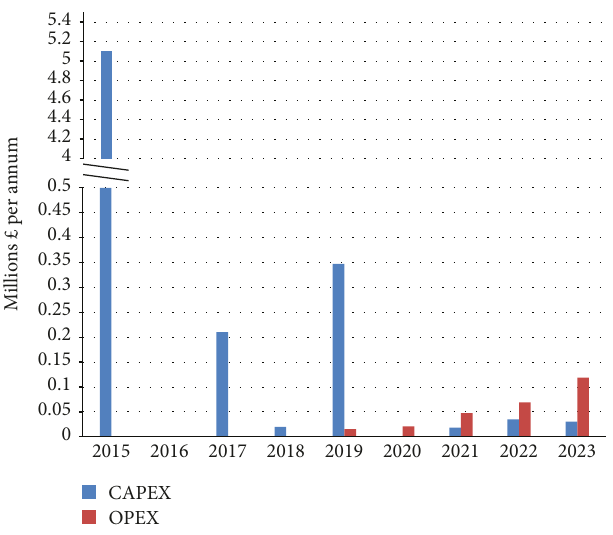
Figure 13: CAPEX and OPEX; DECC2, 2015 –